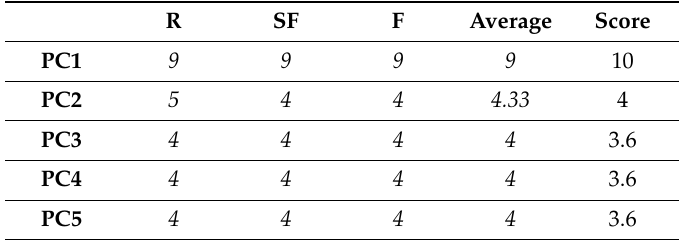
Table 4. Maturity assessment on the basis of